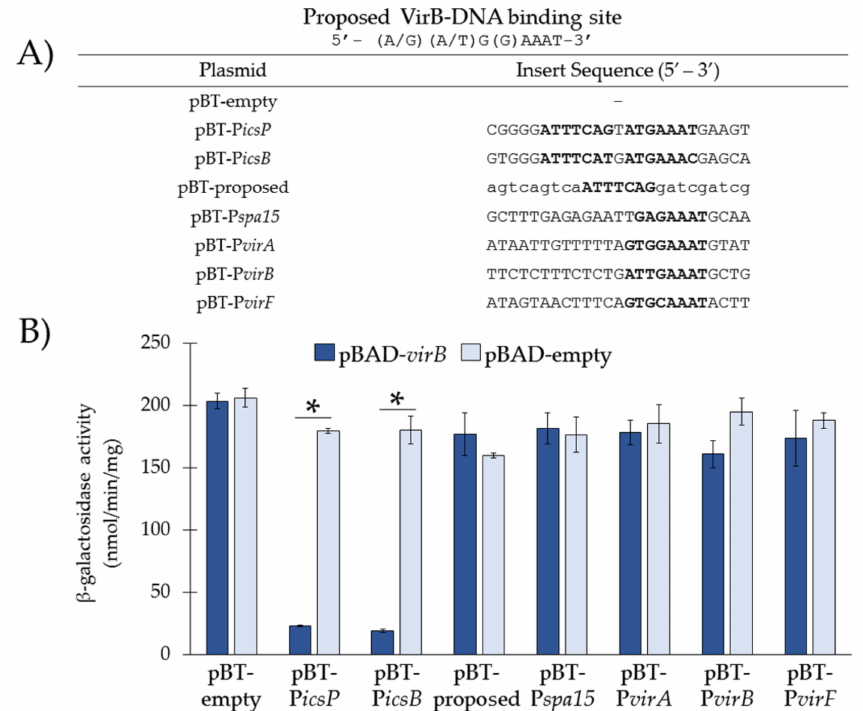
Figure 3. Re-examination of VirB-binding sites described in the literature using our in vivo binding tool. ( A ) DNA sequences inserted into pBT-empty. Putative VirB-binding sites described in the literature are in bold. Uppercase nucleotides refer to native sequences or the proposed site; lowercase nucleotides refer to scrambled sequences. ( B ) P tac activities were measured in the presence (pBAD- virB ) or absence (pBAD-empty) of VirB in a S. flexneri virB mutant using β -galactosidase assays. Data is representative of three independent trials and * denotes a statistical significance of p <